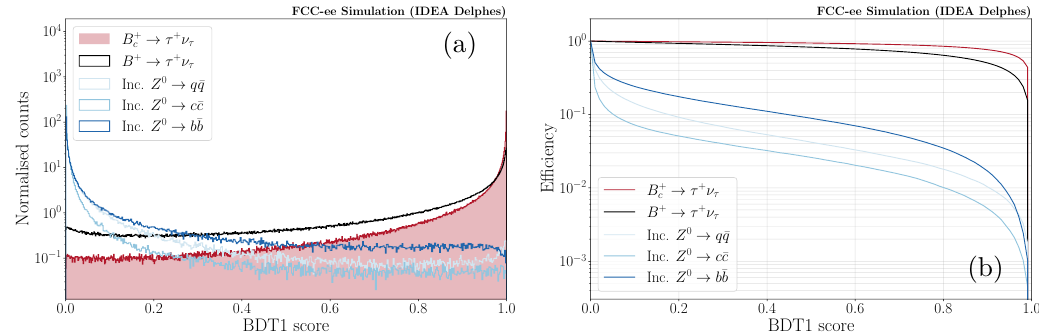
Figure 2 . (a) First-stage BDT distribution in signal, B + → τ + ν τ background, and inclusive Z background. (b) Efficiency of the first-stage BDT as a function of cut